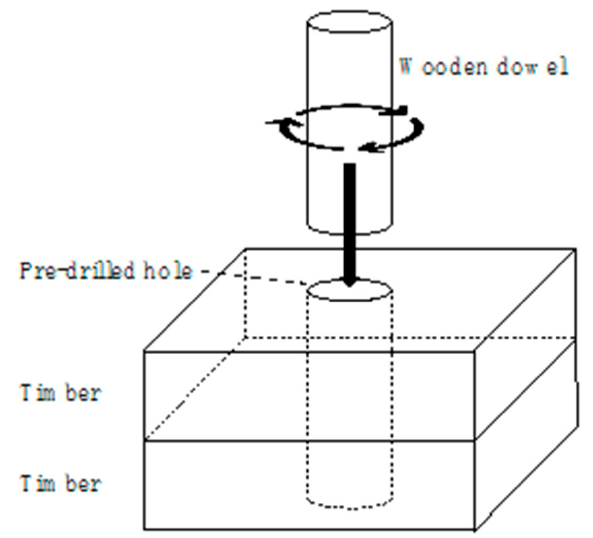
Figure 4. Schematic representation of wooden dowel rotary